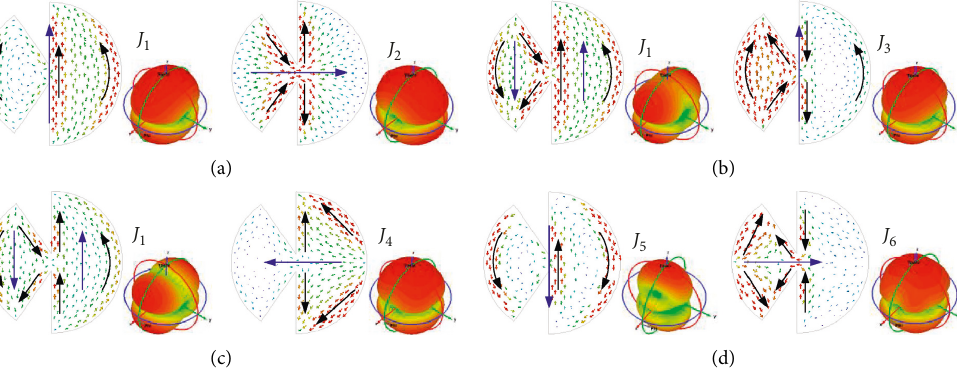
Figure 4: Modal currents and radiation patterns for the radiator of (a) modes J J 1 and J 4 at 5.6GHz. (d) Modes J 5 and J 6 at